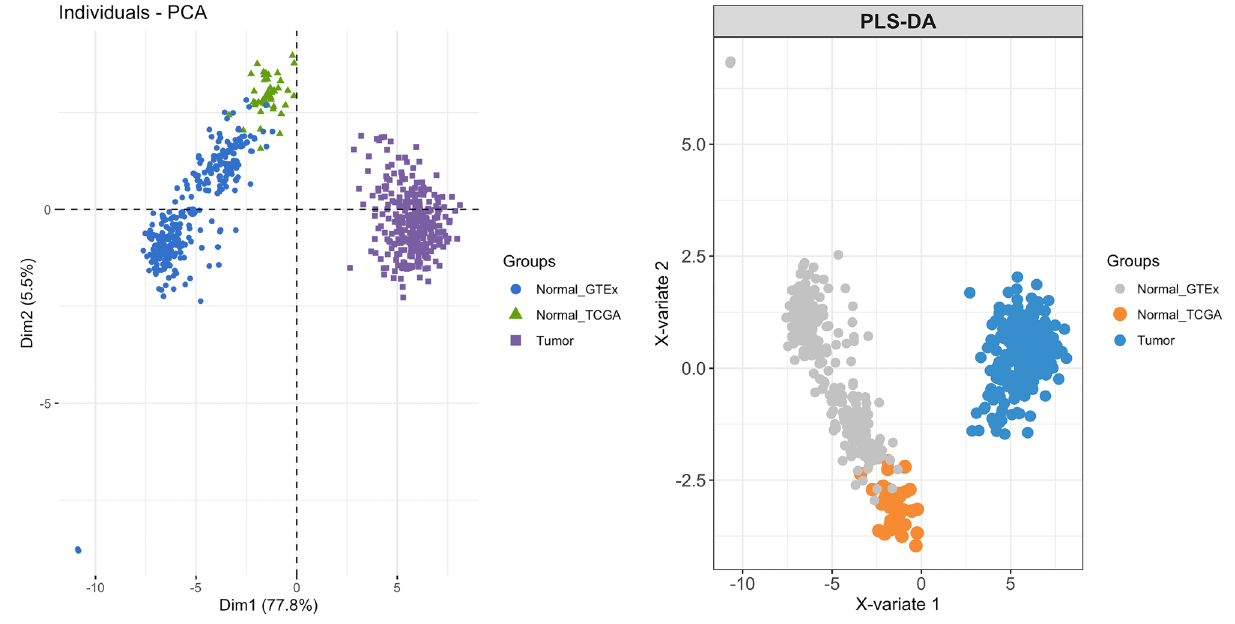
Figure 4. PCA and PLS-DA plot based on the expression pattern of the 38 genes. The analysis was performed using the “FactoMineR” package for PCA and the “mixOmics” package for PLS-DA in R. Each dot, triangle, and square represent a sample.